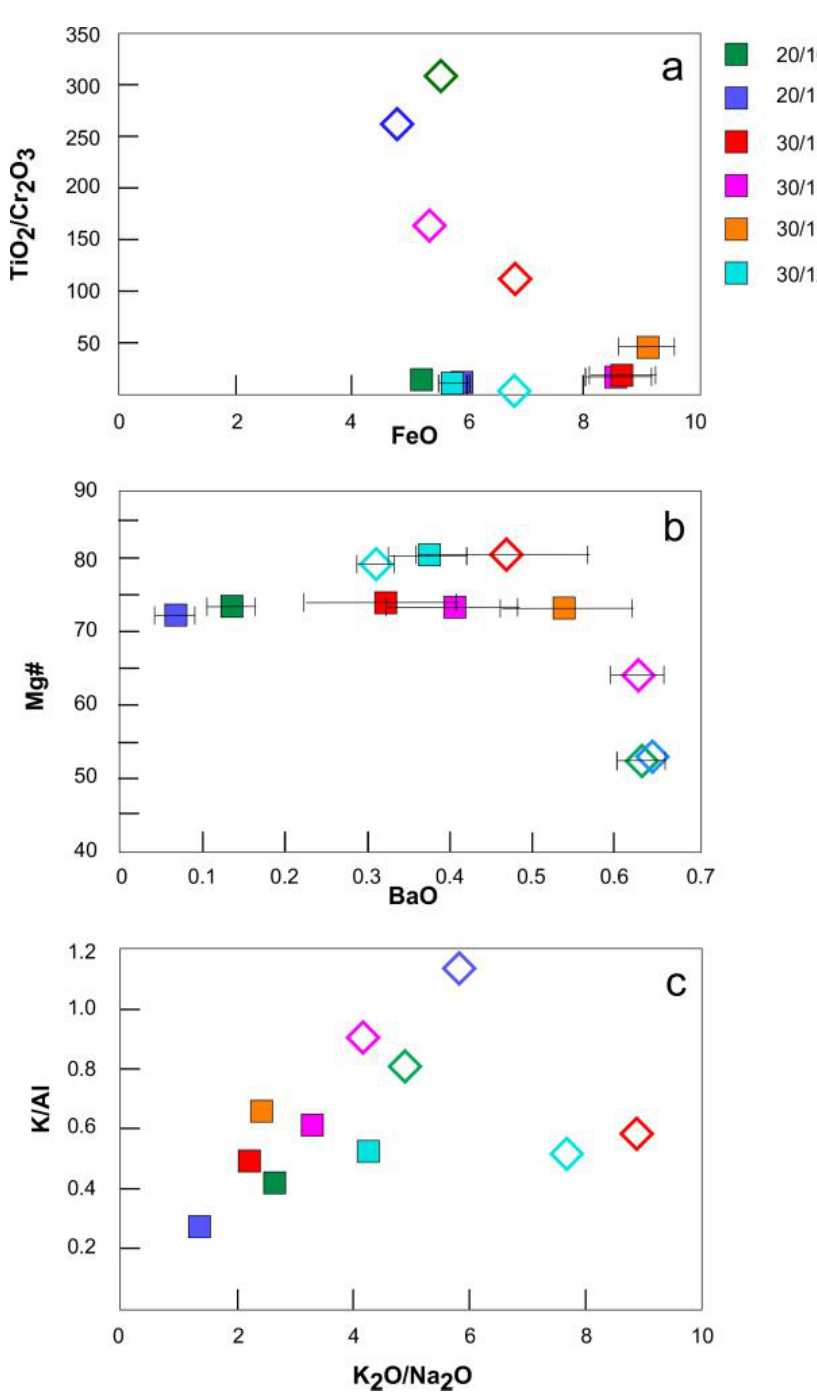
Figure 6. Comparison of melt compositions in melt traps (squares) with melts in the residual lamproite section (diamonds): each symbol is the average for one experiment and colours indicate same experiments (see key). Changes across the peridotite reaction column show similar trends to phlogopites due to buffering of the melt Mg# by the peridotite (middle) and the uptake of TiO 2 but release of Cr 2 O 3 in the metasomatic reaction ( a ). The growth of phlogopite in the peridotite also results in lower BaO and near-constant Mg# ( b ), and in lower K 2 O, hence lower K/Al and K 2 O/Na 2 O ( c ).